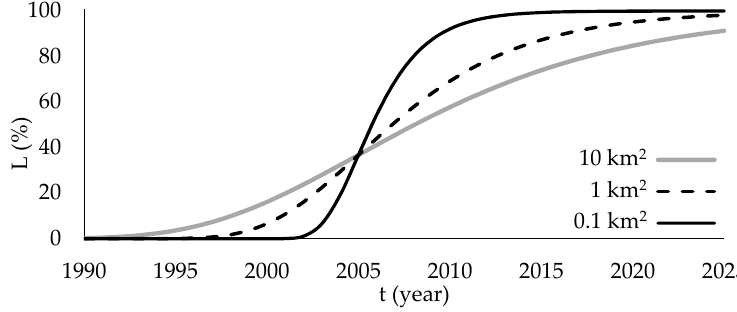
Figure 1. S-curve shape in relation to the area size [1].